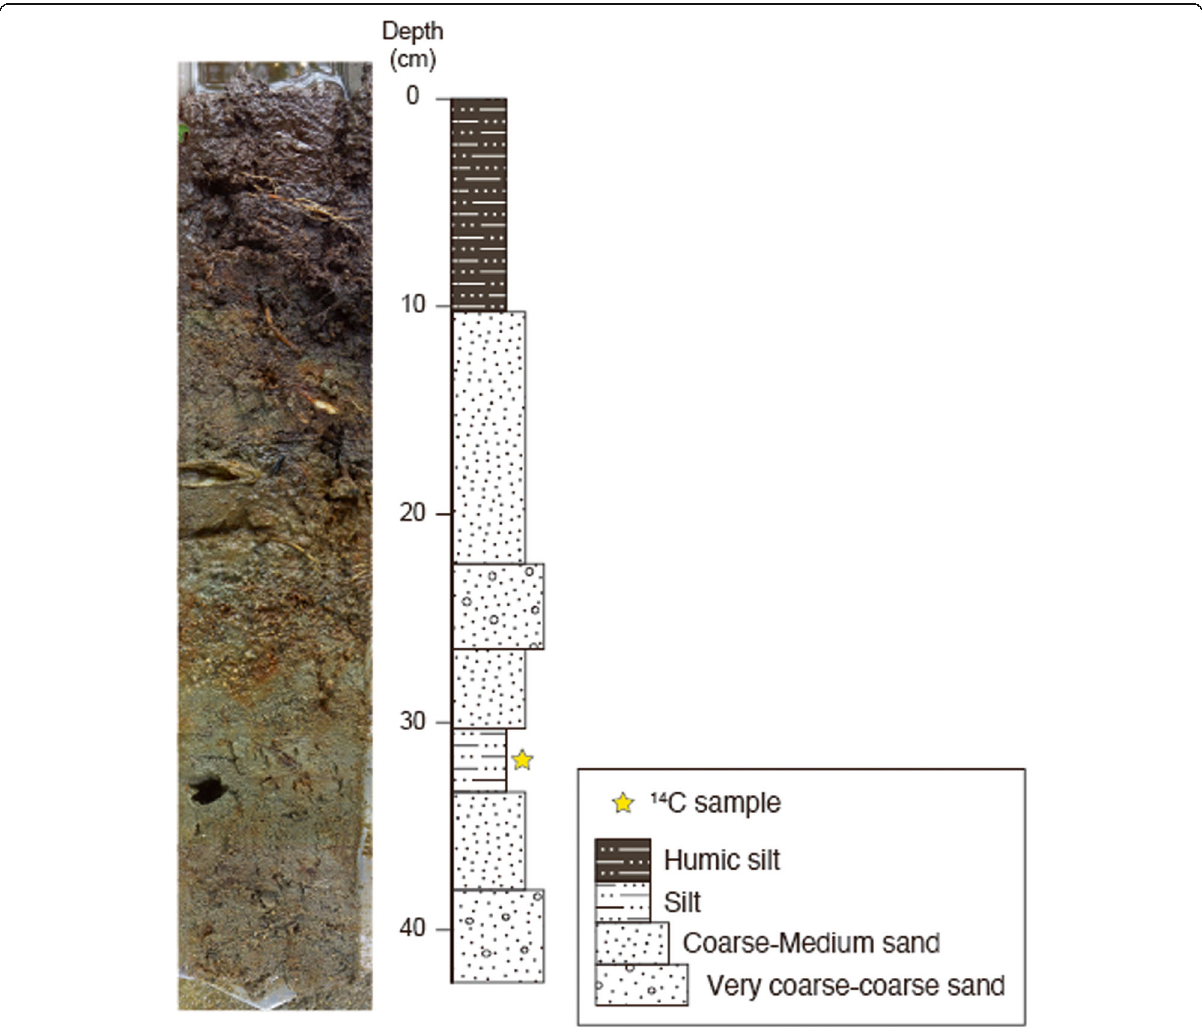
Fig. 8 Shallow stratigraphy of a pond shown in Fig. 3c. To determine the depth of the gravel layer of T5, we inserted a geoslicer and a soil sampler until they hit gravel and stopped; we repeated this measurement many times. We confirmed that the thickness of swamp deposits was 30 – 50 cm from the surface, which suggested that radiocarbon samples we obtained were from the bottom of the swamp deposits and, thus, were suitable for estimating the age of